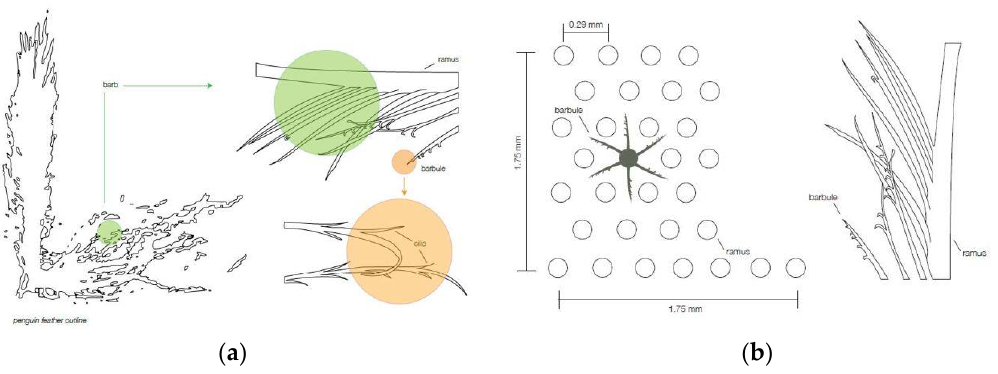
Figure 6. ( a ) Feather structure of penguin [41]; ( b ) Feather distribution on penguin